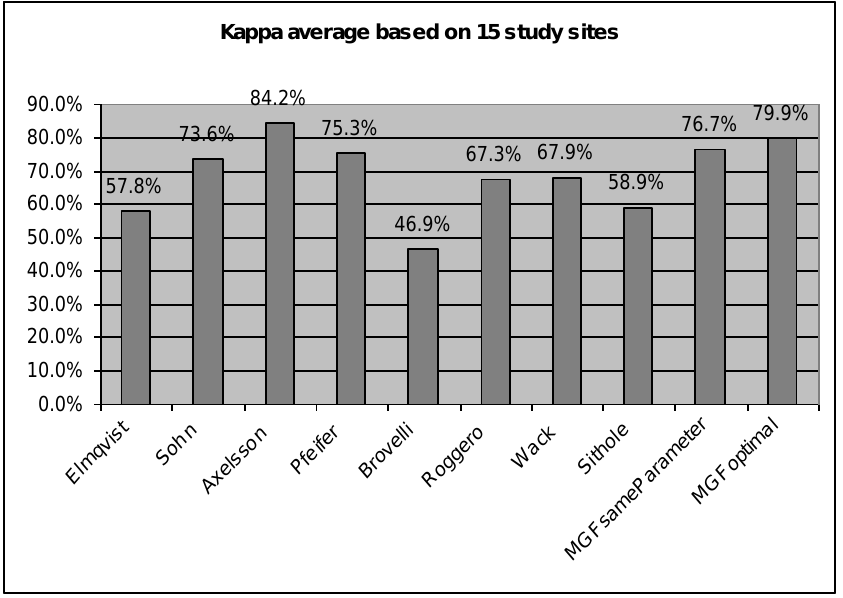
Figure 3. Kappa averages on fifteen sites for nine filters (source